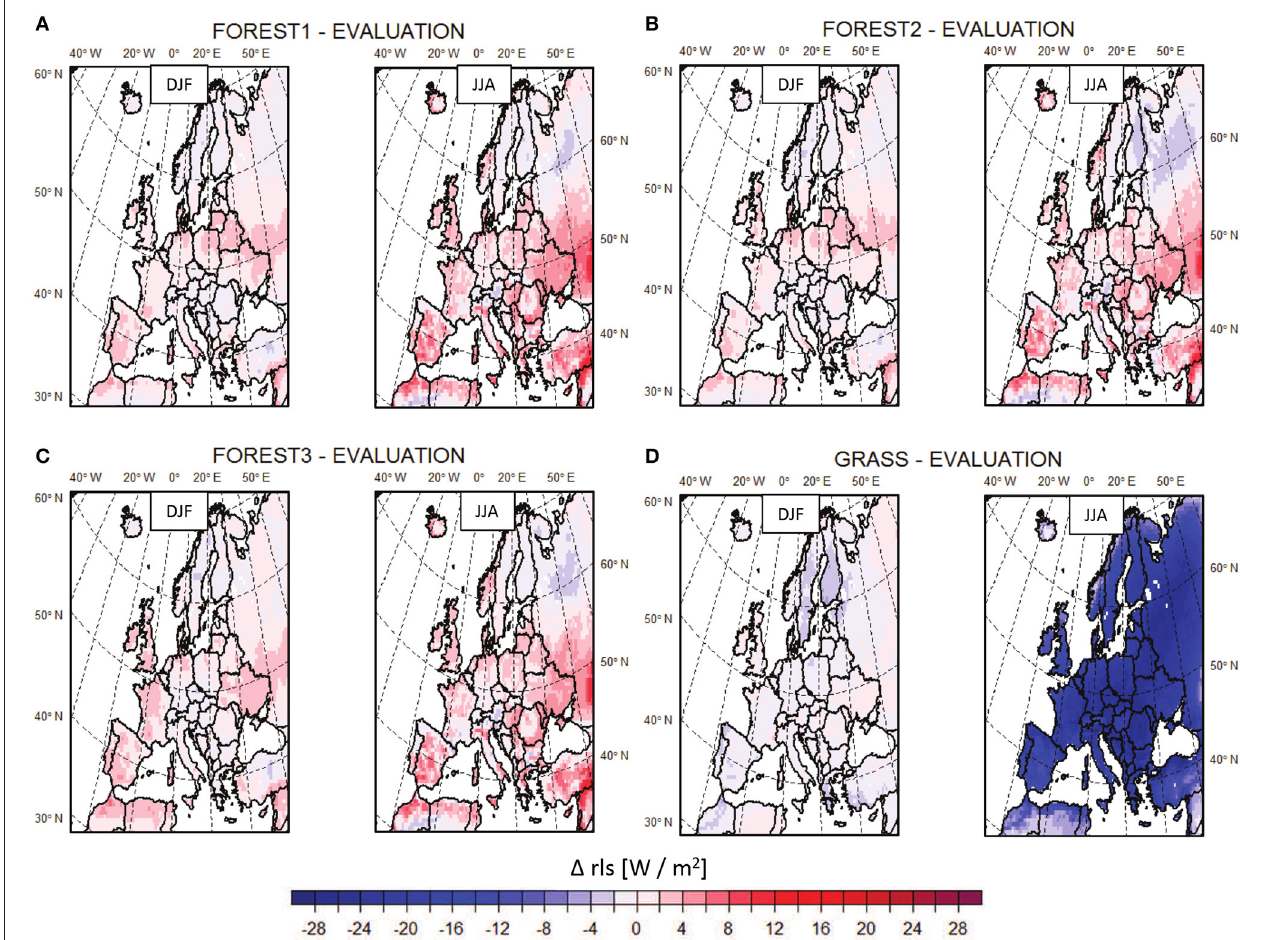
FIGURE 9 | Spatial distribution of mean net longwave flux changes over the EURO-CORDEX domain for the conversion to forest with three different albedo parameterizations [FOREST1 (A) , FOREST2 (B) , FOREST3 (C) ], and to grassland [GRASS (D) ] for winter (DJF, left) and summer (JJA, right) for 1986–2015. The difference between experiments and the EVALUATION simulation with no land cover change is displayed over land points only.